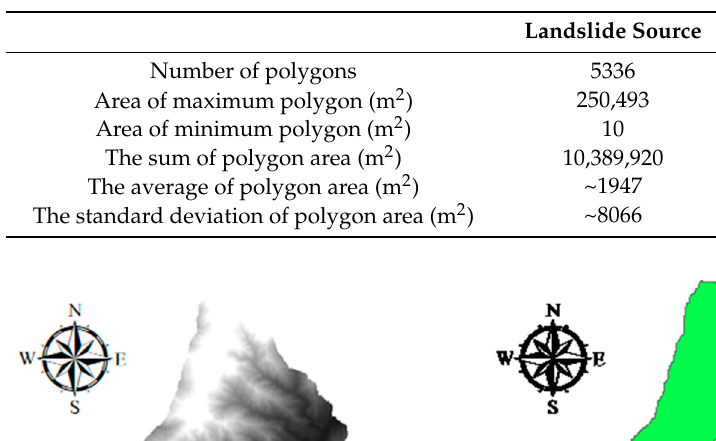
Table 1. Landslide inventory information.